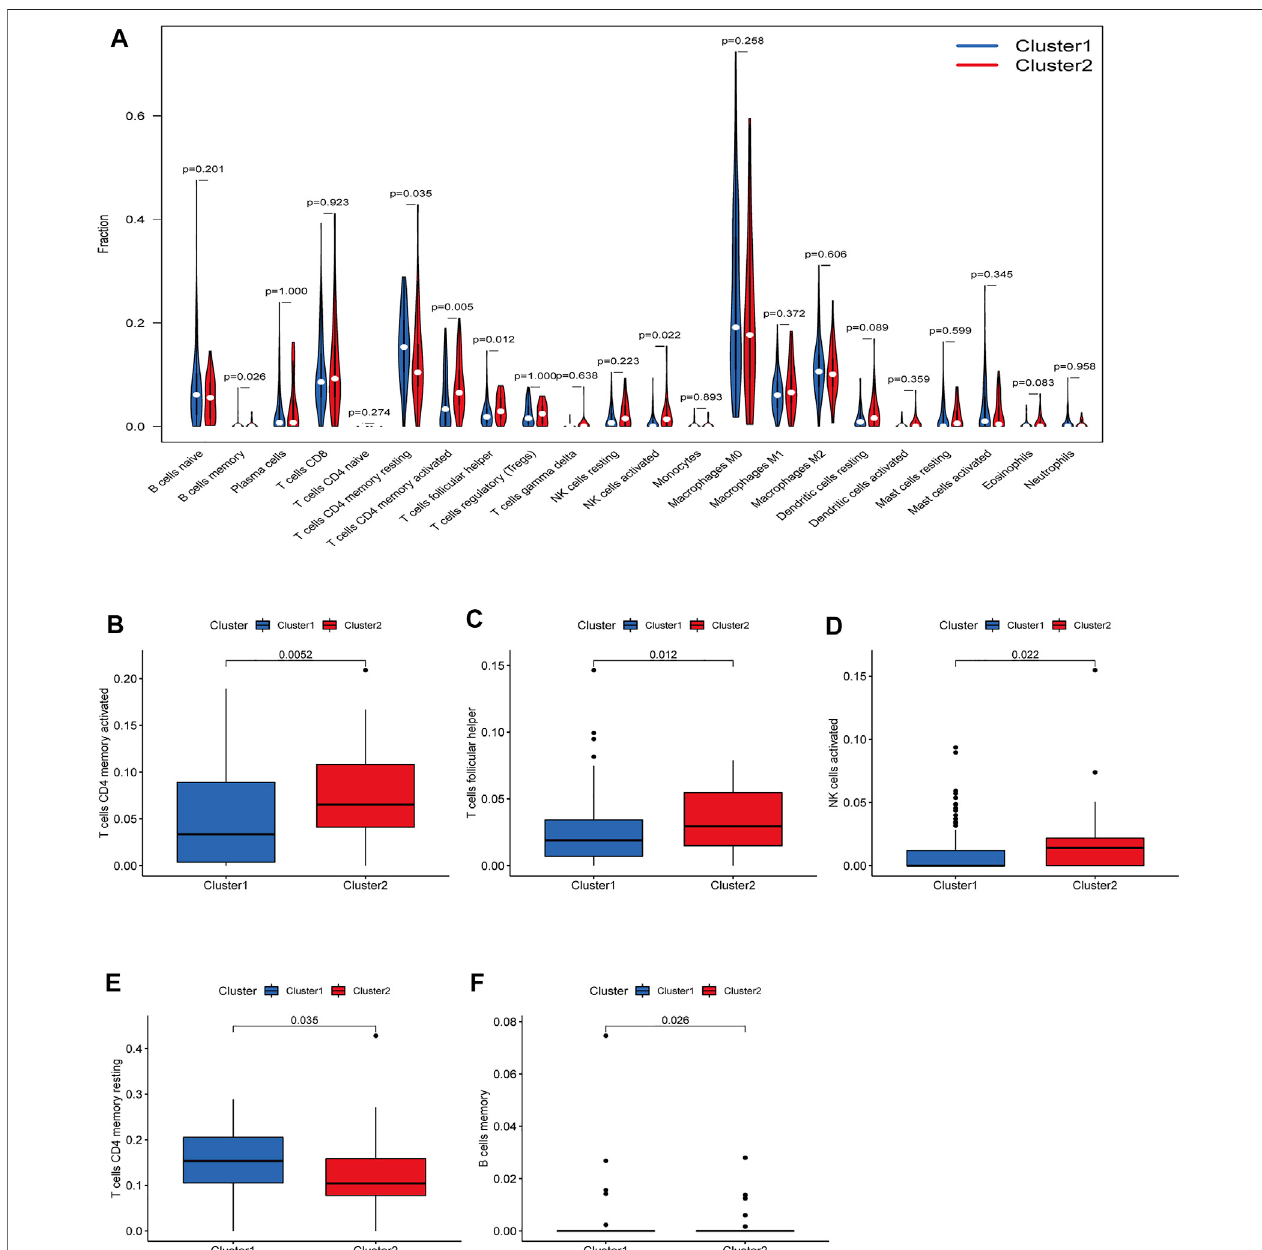
FIGURE 10 | Diferent analysis of immune cell in fl tration in the two clusters. (A) Vioplot; (B – F) Boxplot. CD4 memory activated T cells, follicular helper T cells and a1186ctivated NK cells were upregulated in type 2, which had a low survival rate.